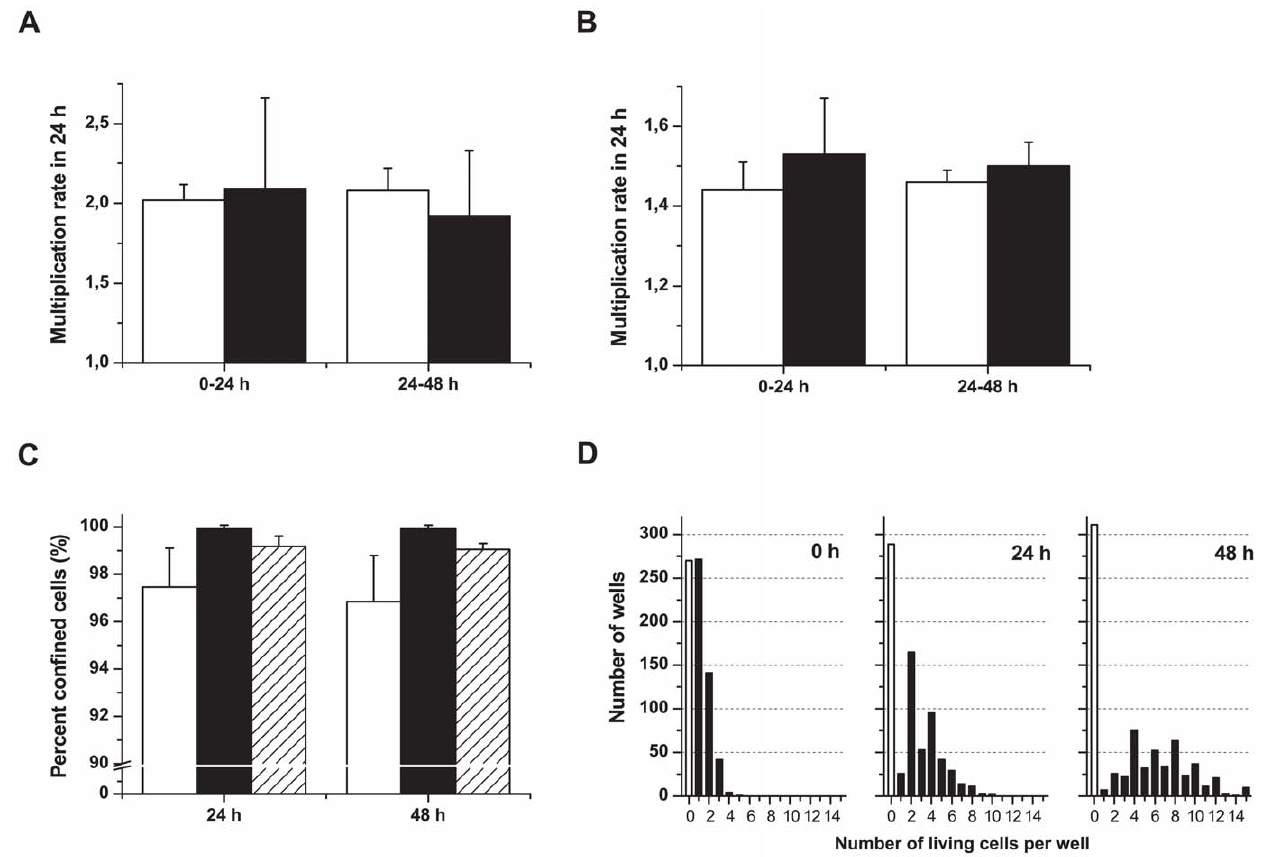
Figure 4. Cell survival and confinement in silicon wells. (A, B) Multiplication rates in the wells (white bars) compared to conventional cell culturing in a tissue culture dish (black bars); 221 cells (A) and YTS cells (B). (C) Level of confinement was measured by quantifying the number of cell- containing wells that had been empty 24 hours earlier and relating it to the total number of empty wells (white bars:221, black bars:YTS, striped bars:293T). The experiments showed a high level of confinement for all three cell types tested. (D) Distribution of 221 cells in the wells over 48 hours after seeding, one representative result out of six is shown. 729 wells were counted in all experiment. The white bar shows the number of empty wells and the slight increase over time is due to cell death in some wells.